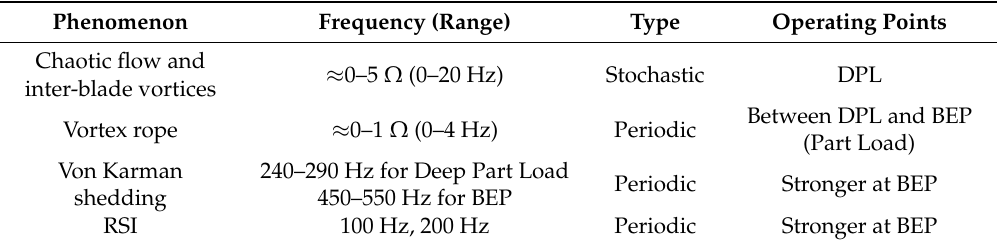
Table 3. Characteristics of the hydraulic excitations in the present